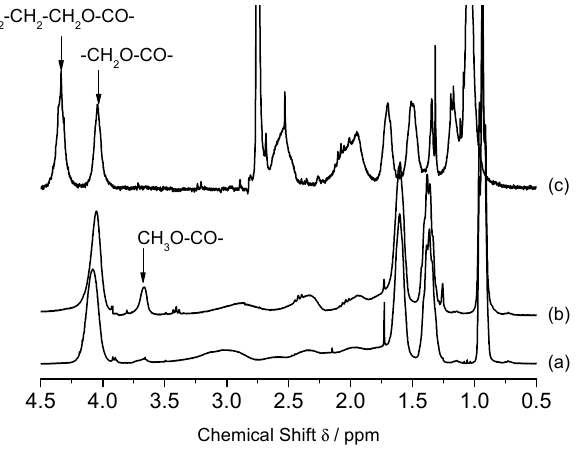
Figure 2. 1 H NMR spectra of: (a) P [BMA 0.9 - co -MAH 0.1 ]; (b) P[BMA 0.9 - co -monomethylmaleate 0.1 ] obtained by methanolysis of (a); and (c) P[BMA 0.44 - co -F8H2MA 0.56 ].